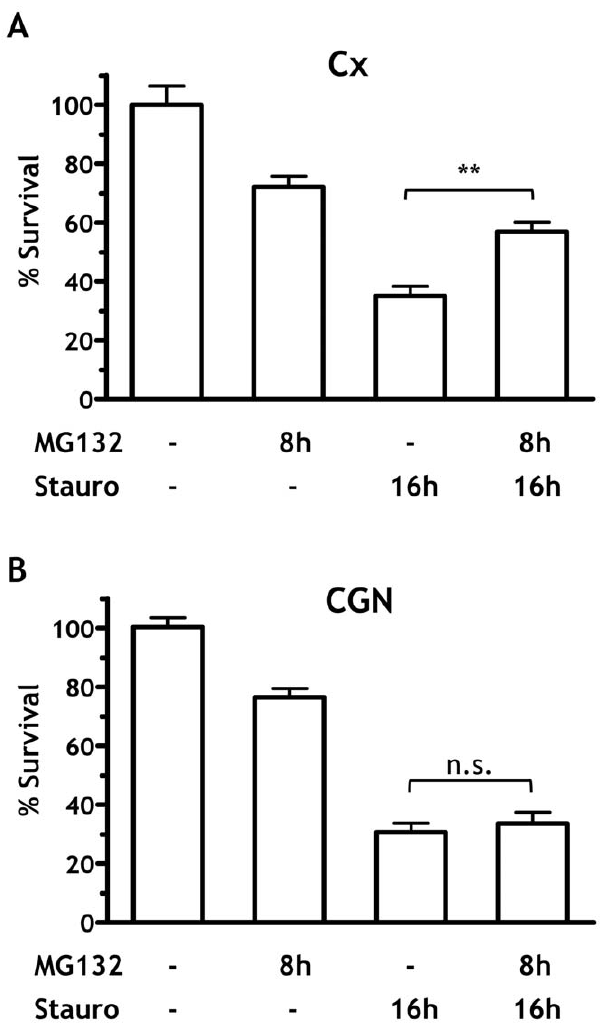
Figure 5. MG132 protects cortical but not cerebellar granule neurons from staurosporine-induced cell death. Cortical (A, Cx) and cerebellar granule neurons (B, CGN) from C57BL/6J mice were exposed to 5 m M MG132 for 8 h to induce accumulation of SP-PrP in cortical neurons, and treated with 100 nM staurosporine or not for 16 h. Cell survival was quantified at the end of the treatment (24 h) by MTT assay and expressed as a percentage of the values for cells treated with the vehicle. Data are the mean 6 SEM of 20–25 replicates from four independent experiments; ** p , 0.01 by Bonferroni test.